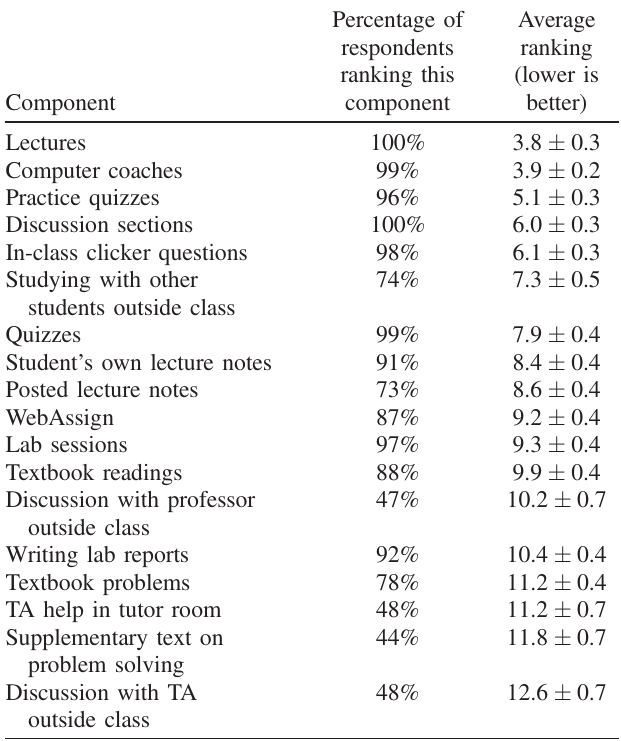
TABLE VI. Results from a fall 2011 survey question asking students to rank (with no ties) the usefulness of 18 components of the class to their learning. Students were asked to rank a component only if they had used it. Lower numbers are better.